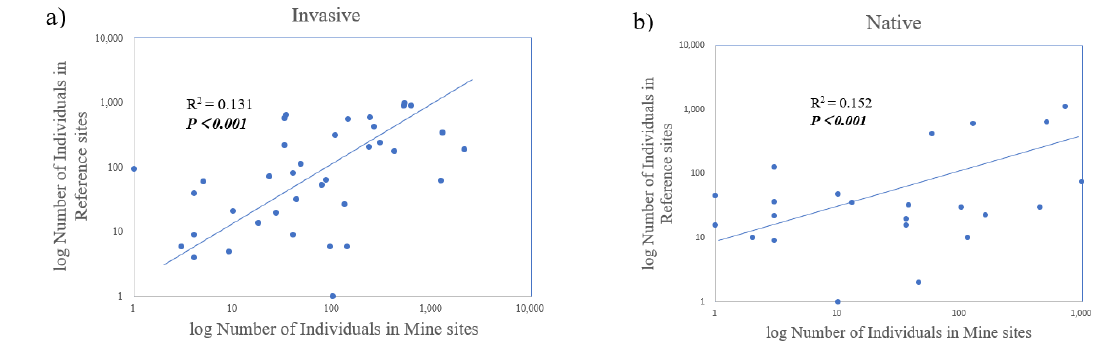
Figure 6. Linear regressions of plant abundance in mine sites versus reference sites for the site pairs at all locations: ( a ) log number of individuals for invasive plants (n = 37) and ( b ) log number of individuals for native plants (n = 23). Each dot point represents an individual species. Values are of the total within each site type, and species absent from either site type were excluded.